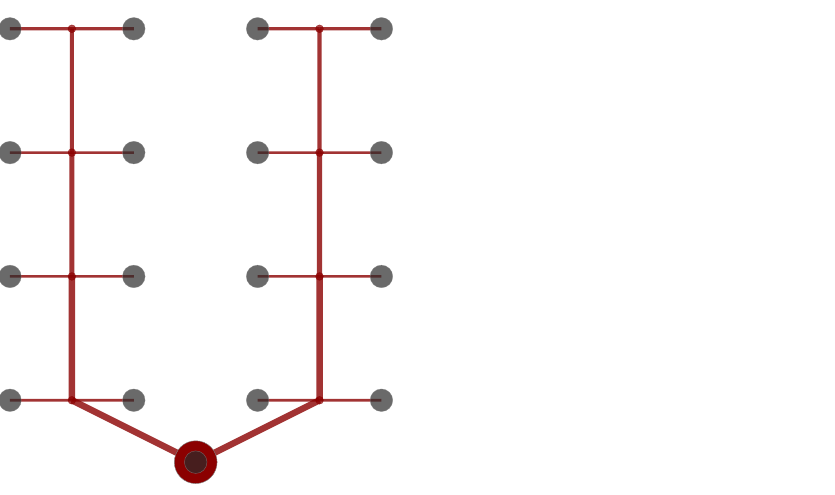
Figure 7. Network layout of the DESTEST network with 16 buildings.